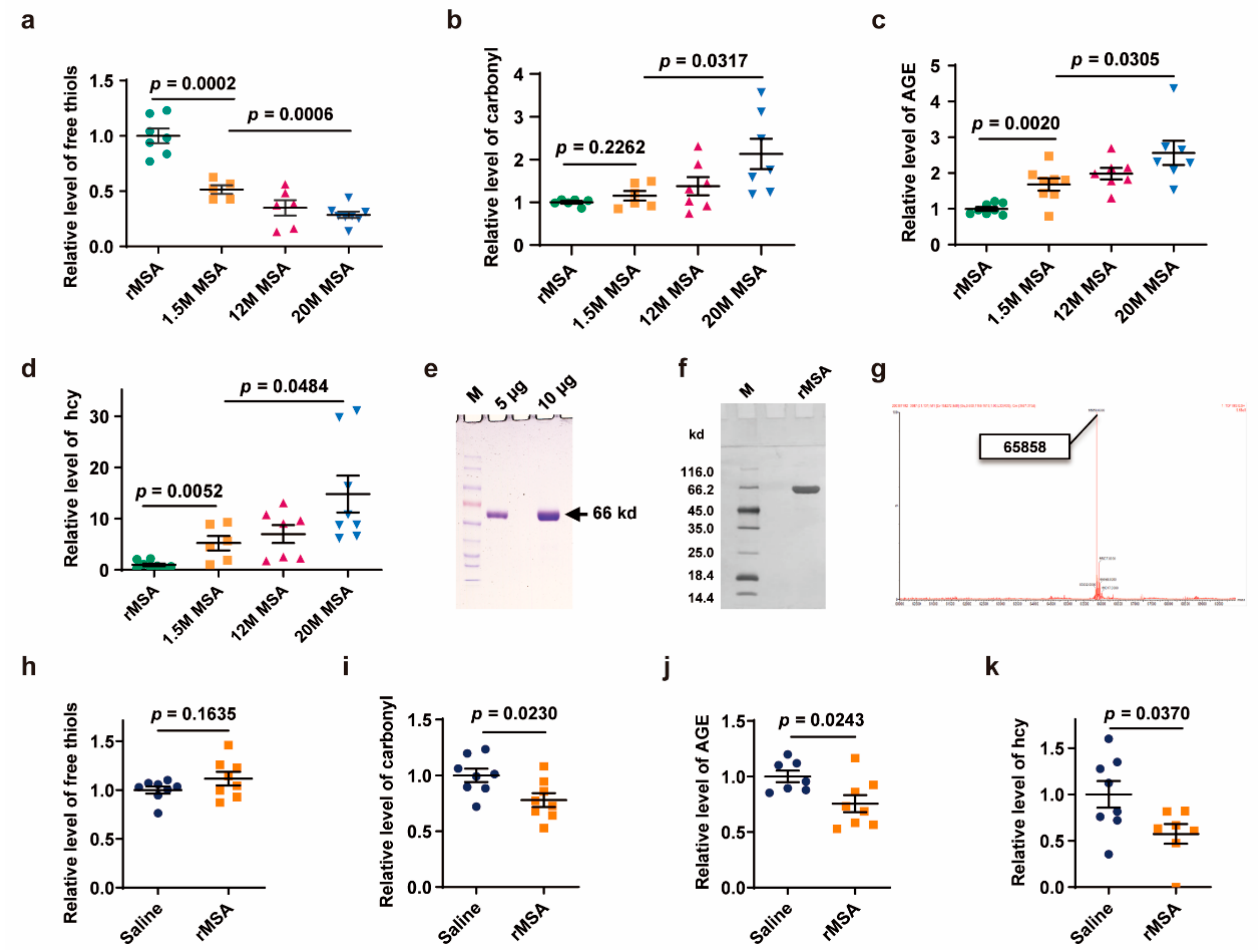
Figure 1. rMSA treatment improved four parameters related to aging. ( a – d ) The level of free thiol ( a ), carbonyl ( b ), AGE ( c ), and hcy ( d ) of rMSA and endogenous albumin from serum samples of mice at 1.5-, 12-, and 20 months of age. ( e – g ) The molecular weight and protein purity of rMSA were verified by SDS-PAGE with Coomassie Brilliant Blue staining ( e ), silver staining ( f ) and mass spectrometry ( g ). ( h – k ) The level of free thiols ( h ), carbonyl ( i ), AGE ( j ), and hcy ( k ) of endogenous albumin of mice treated with body weight-adjusted dosage of rMSA or isometric saline. All graphs represent mean with SEM, with p values calculated by the two-tail t test.